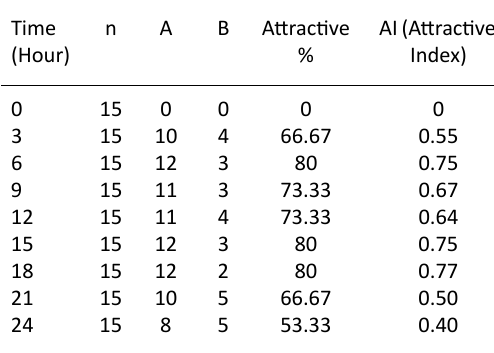
Table 4. Biological Activity Assays of the fractions